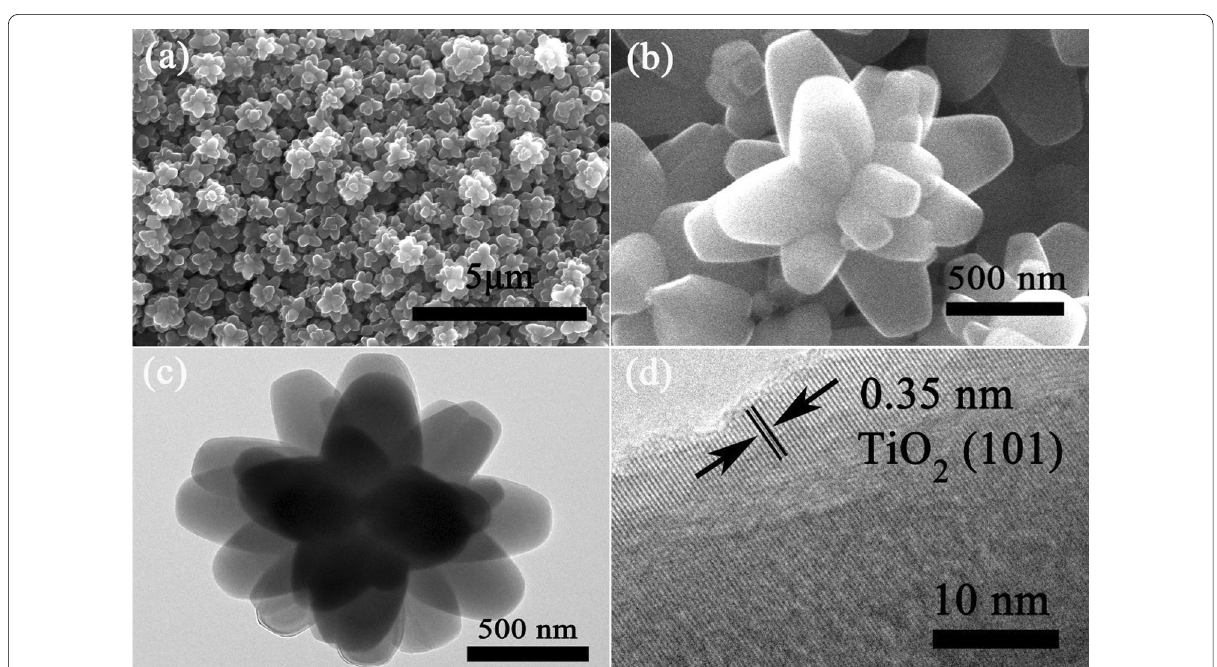
Fig. 2 a , b SEM images of TiO 2 FLNMs at low and high magnifications, respectively; c TEM image of TiO 2 FLNMs; d HRETM image